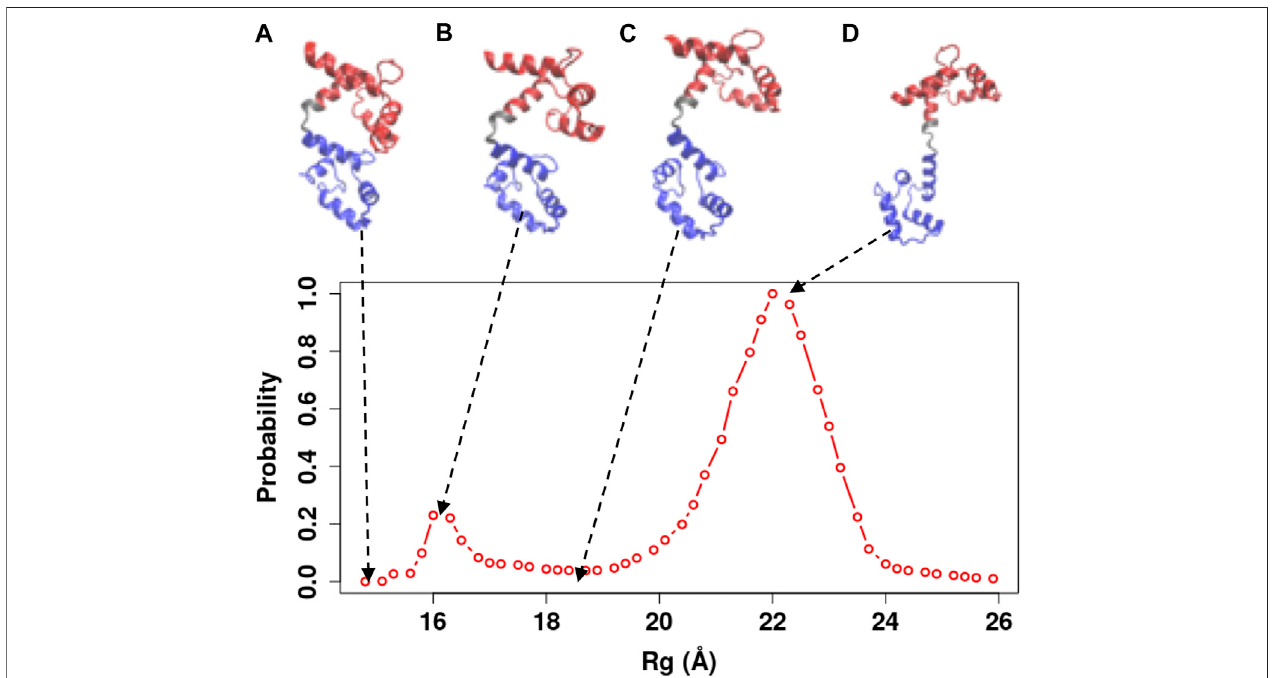
FIGURE 7 | Representative snapshots of the Ca 2+ -CaM model obtained from our simulations. The model that best reproduces experimental measurements was used ( λ FM (cid:1) 0 . 1, W others